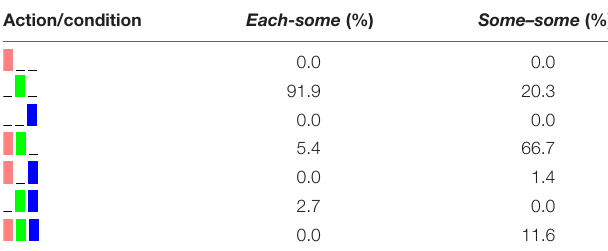
TaBle 1 | Combinations of different reward choices for each-some and some- some sentences.